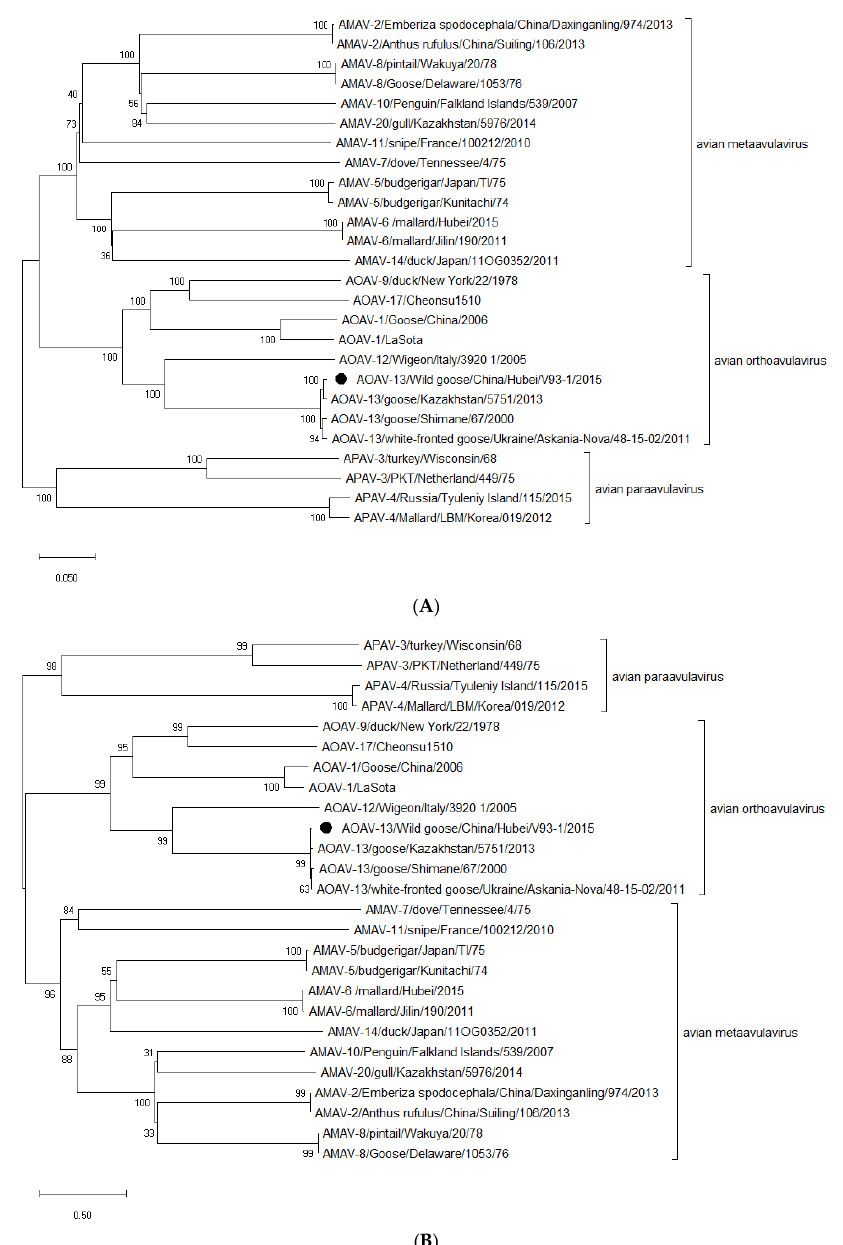
Figure 2. Phylogenetic analysis of the whole genome sequence ( A ) and entire F gene sequences ( B ) of AOAV-13 and other serotype viruses. In line with other studies [5–10], three genera ( Metaavulavirus , Orthoavulavirus and Paraavulavirus ) exist in the subfamily Avulavirinae , including 20 described serotypes (-1 to -20), as revealed by genetic relationships of the whole genome sequence ( A ) and entire F gene sequences ( B ) of all viruses within Avulavirinae . As shown in Figure 2A,B, Metaavulavirus contains ten species of avian metaavulavirus (AMAV), including serotypes -2, -5, -6, -7, -8, -10, -11, -14, -15 and -20, Orthoavulavirus contains eight species of avian orthoavulavirus (AOAV), including serotypes -1, -9, -12, -13, -16, -17, -18 and -19, while only two serotypes (-3 and -4) of avian paraavulavirus (APAV) are grouped into the genus of Paraavulavirus [11]. The evolutionary history was inferred by using the maximum likelihood method based on the Tamura–Nei model. The optimal tree with the sum of branch length of 3.61319067 ( A ) and 21.37661970 ( B ) is shown. The analysis involved 26 ( A ) and 26 ( B ) nucleotide sequences. There were a total of 12,066 ( A ) and 1414 ( B ) positions in the final